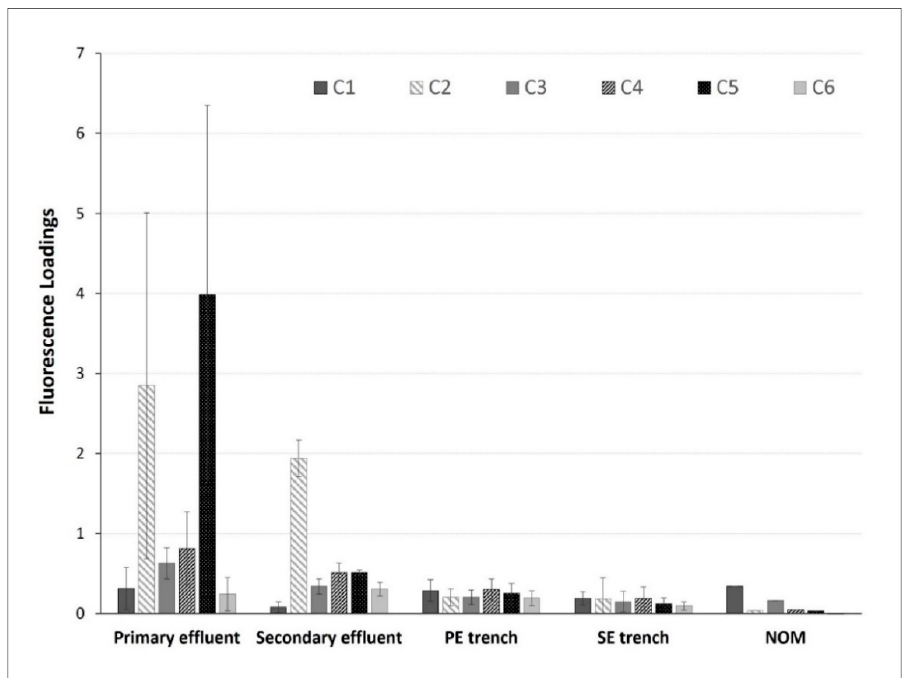
Figure 2. Total fluorescence intensity loadings for effluent and percolation trench samples from February and March 2017. C1 is attributed to HA, C2 to FWCs, C3 to soil HA, C4 to FA, C5 to protein-like (tyr & trp) compounds and C6 to tryptophan.